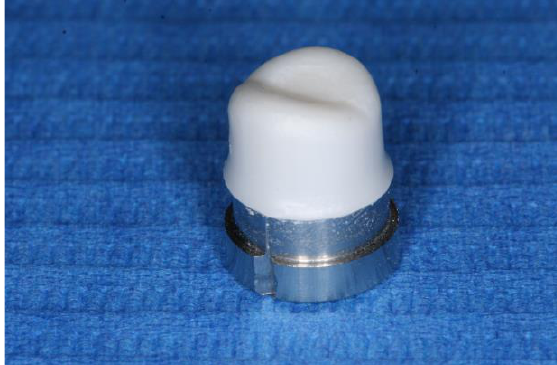
Figure 2. Zirconia coping cemented with a pressure of 20 N with the cement excess